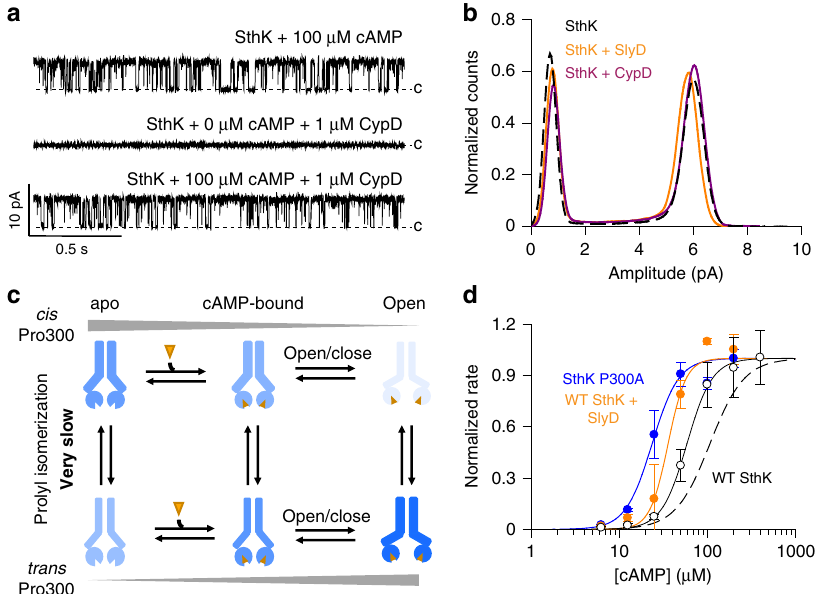
Fig. 3 Effect of PPIases on the gating of SthK. a Representative single-channel recordings of WT SthK at + 100 mV in the presence of 100 µ M cAMP, 0 µ M cAMP + 1 µ M CypD, and 100 µ M cAMP + 1 µ M CypD, as indicated. Dashed lines indicate the closed level. b Normalized all amplitude histogram from single-channel recordings of WT SthK in the presence of 100 µ M cAMP, without PPIase (black, dashed line) and in the presence of 1 µ M SlyD (orange) or 1 µ M CypD (purple) at + 100 mV. These experiments were performed three times with similar outcome. c Schematic state model (blue cartoon is the channel, orange triangle is the ligand) for the proline switch in SthK. Column labels indicate apo, cAMP-bound, and open states. Row labels indicate cis and trans Pro channel forms. Vertical transitions are modulated by prolyl isomerization. Gradient lines indicate the shift in the cis / trans equilibrium between the apo and the open state. d Initial rates of Tl + fl ux obtained from the stopped- fl ow assay (Eqs. (2) and (3)) are plotted as functions of the cAMP concentration. Lines represent fi ts according to Eq. (4). Data with 2.5 s delay time are shown for SthK P300A in blue (EC 50 = 24 ± 2 µ M, n H = 2.9 ± 0.6, n = 3 independent experiments), WT SthK in the presence of 1 µ M SlyD in orange (EC = 36 ± 2 µ M, n = 4 ± 0.9, n = 3 independent experiments). The 50 H fi t for WT SthK in the absence of PPIase is shown as dashed line. WT SthK after about 45 min delay time is shown as open circles and the fi t as continuous black line (EC 50 = 59 ± 1 µ M, n H = 3 ± 0.9, n = 4 independent experiments). Symbols represent mean ± S.D. Source data are provided as a Source Data fi